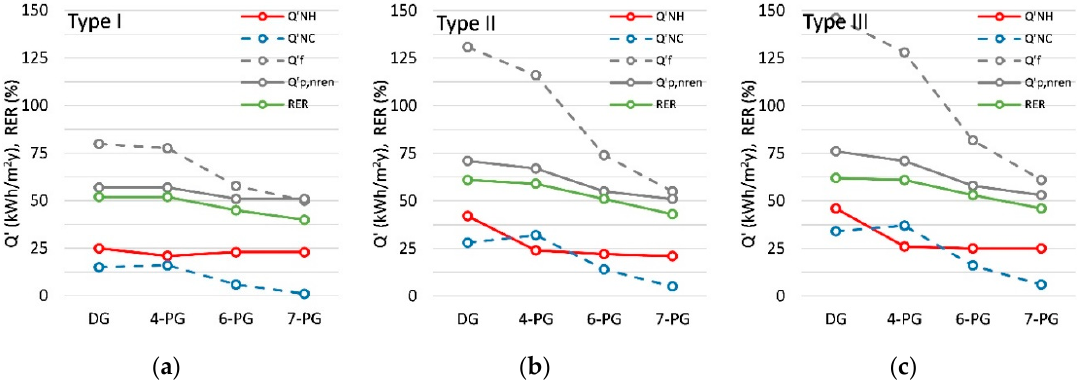
Figure 7. Energy efficiency and nZEB indicators of the buildings built with advanced glass and BIPV facade structures in Type I ( a ), Type II ( b ), and Type III ( c ) buildings in Helsinki.